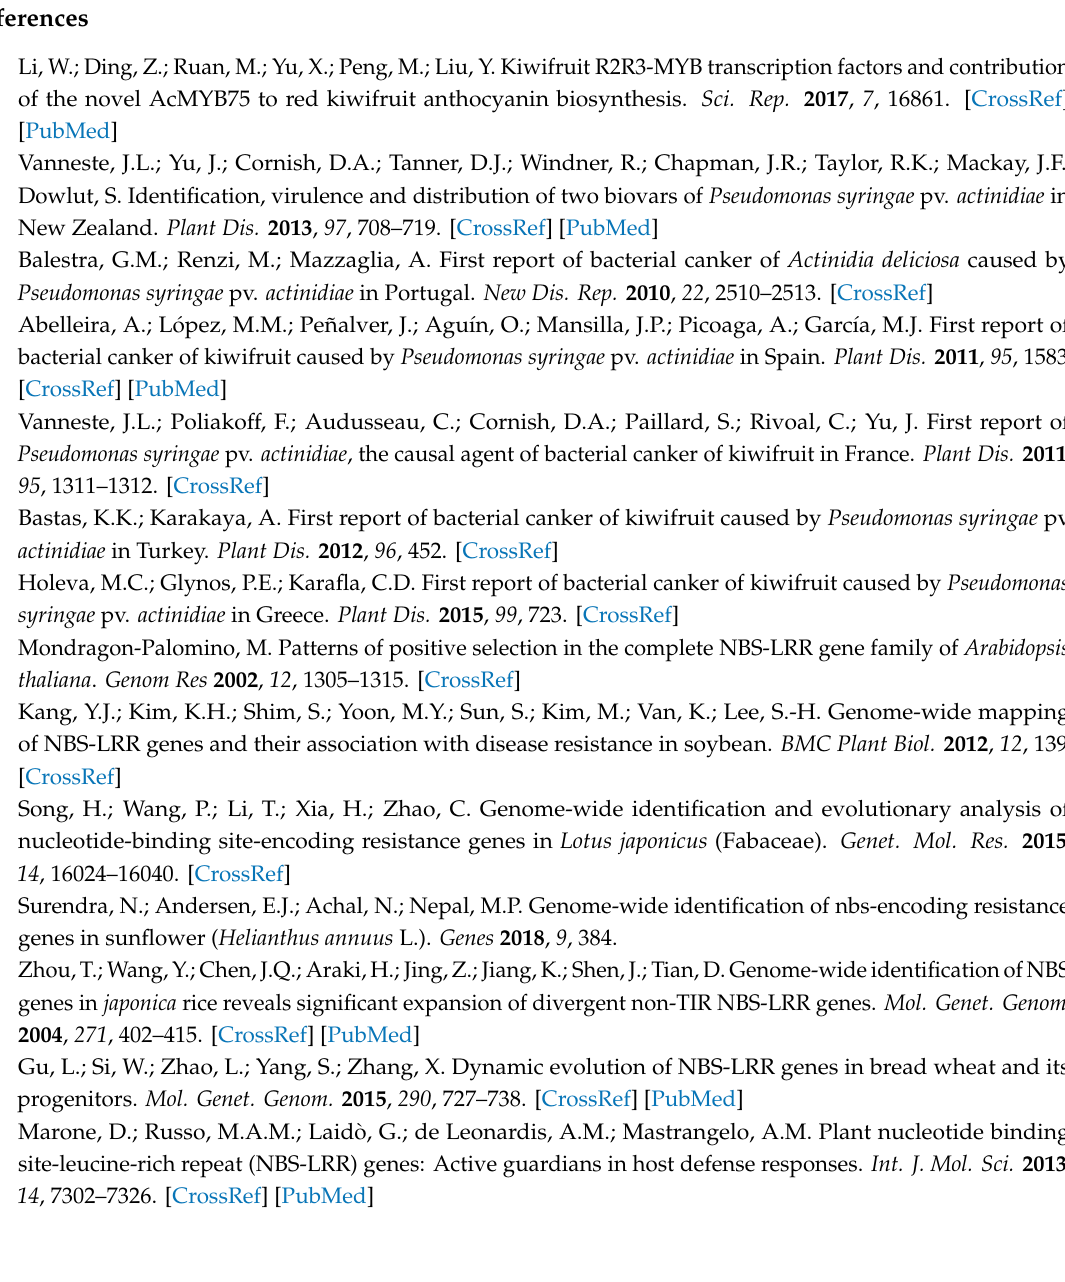
s1. Figure S1:Cis-acting elements of promoters of the NBS-LRR genes, Table S1: Data of the 100 NBS-LRR protein coding sequences, Table S2: Subcellular location prediction of the NBS-LRR genes, Table S3: List of primers used in